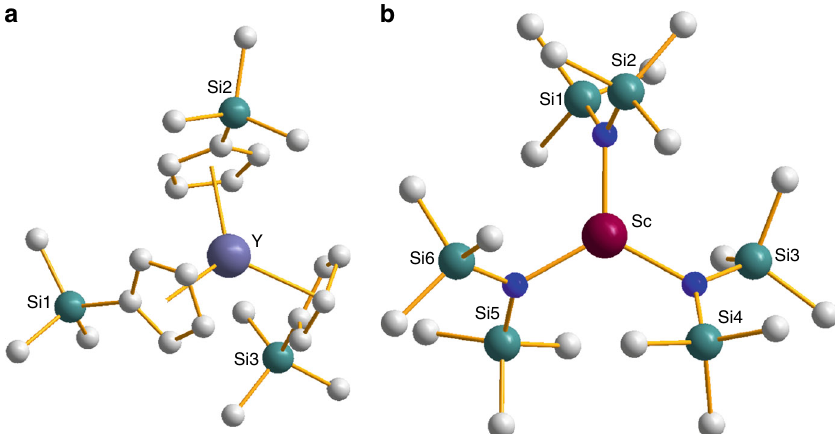
Fig. 1 Molecular structures in the crystal. a The [Y(Cp ′ ) 3 ] − anion in 1. b The [Sc{(N(SiMe 3 ) 2 } 3 ] − anion in 4 . Grey unlabelled atoms are carbon; blue unlabelled atoms are nitrogen. H-atoms omitted for clarity